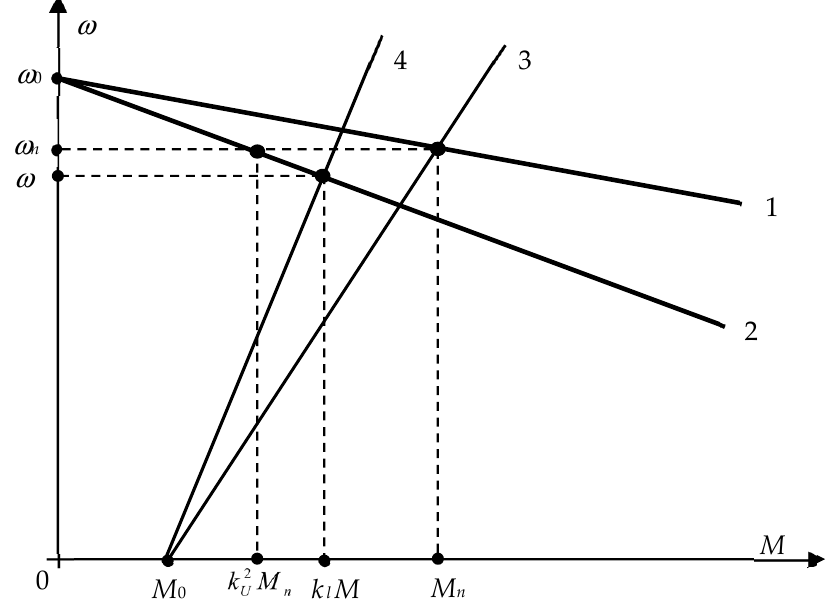
Figure 4. Mechanical characteristics of the induction motor and the working machine.